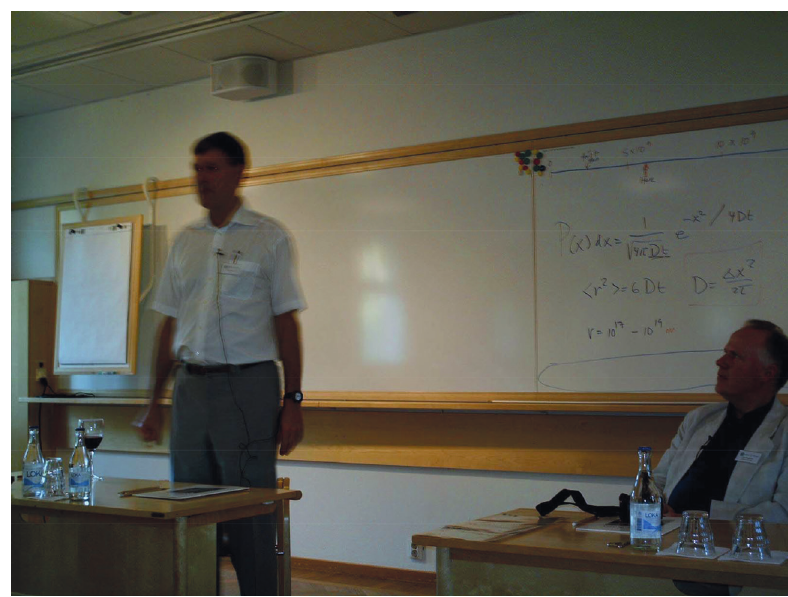
Figur 2. Vid ett Alfred Nobel Symposium: “Energy in Cosmos, Molecules and Life” i Sånga Säby 2005, framför författaren här en inspirerad (notera vinglaset!) spekulation kring möjligheten att livet skulle ha uppstått någon annanstans i universum än på jorden. En beräkning gjord bokstavligen ”on the back of an envelope” (se kuvertet till höger, daterat 100 år efter att Einstein färdigställde sin doktorsavhandling) utnyttjar hans ekvation (14) för att uppskatta hur långt en bakteriespor skulle kunna ha migrerat i rymden driven av t.ex. solvinden som kan antas slumpvis byta riktning mellan solsystemen (steglängden). ”Restiden” antas vara maximalt 10 10 år dvs. från att de första planeterna kallnat och till dess liv på jorden först daterats. Bakterien Deinococcus Radiodurans som visat